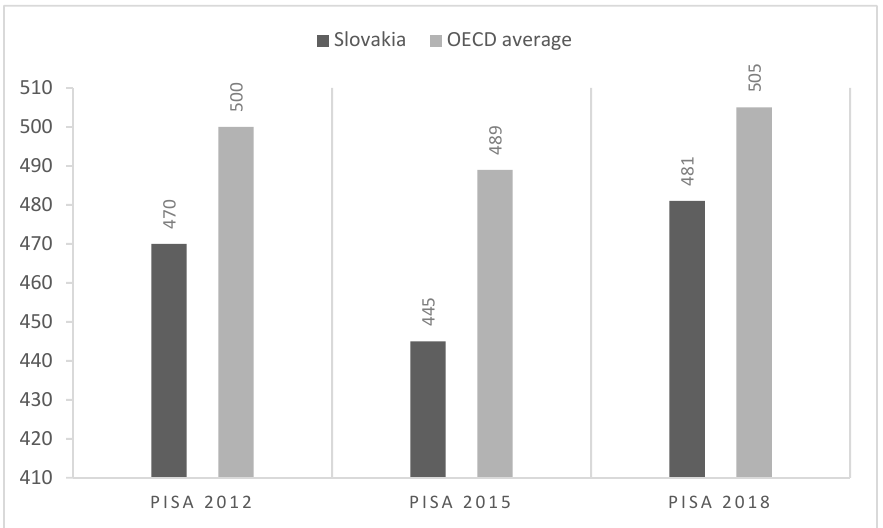
Figure 1. Results of PISA testing 2012, 2015, and 2018.